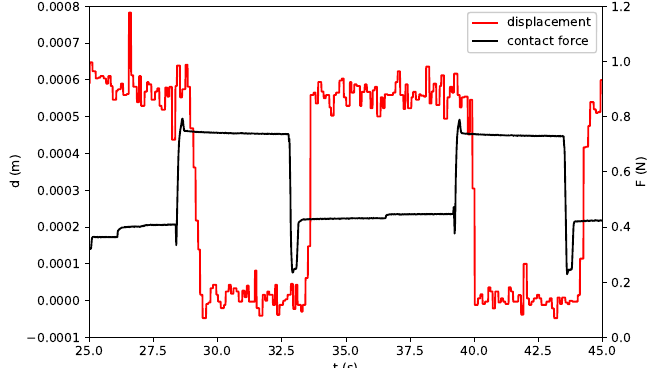
Figure 20. Contact force for the thumb and the displacement d of the thumb tip during manipulating the white rubber (Figure 18e).